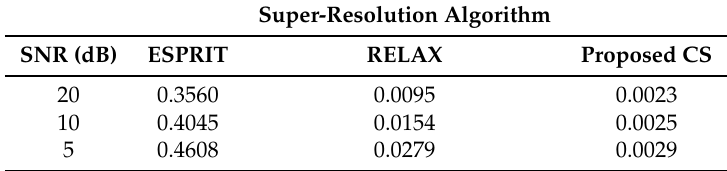
Table 3. MSEs of the estimated position using the ESPRIT, RELAX and proposed CS algorithms under different signal-to-noise ratios (SNRs).